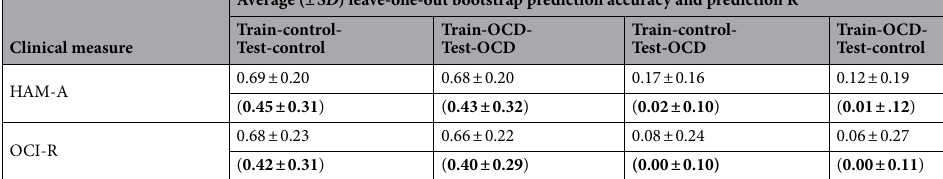
Table 2. Average (± SD ) leave-one-out bootstrap prediction accuracy and prediction R 2 (in brackets and bolded) for the two clinical measures estimated across 1000 permutations. Prediction R 2 is indicated